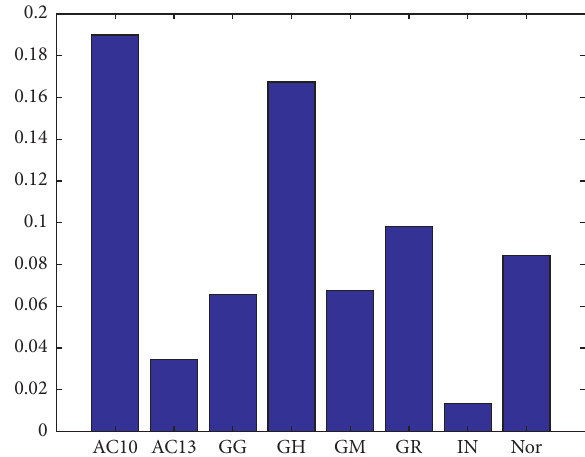
Figure 5: The weights of each CMIP5 model based on BMA. Table 7: The Rbias between the monthly observed precipitation and the simulation performance of individual GCMs, MME, and BMA simulation in the period of 1961–2005 (%).